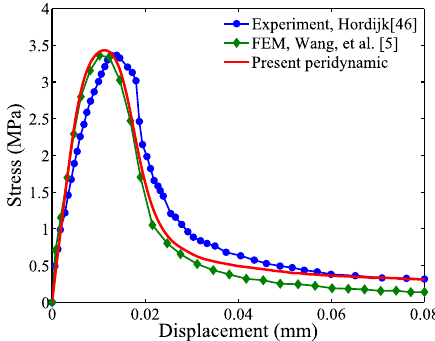
Figure 12. Comparison with experimental and available FEM